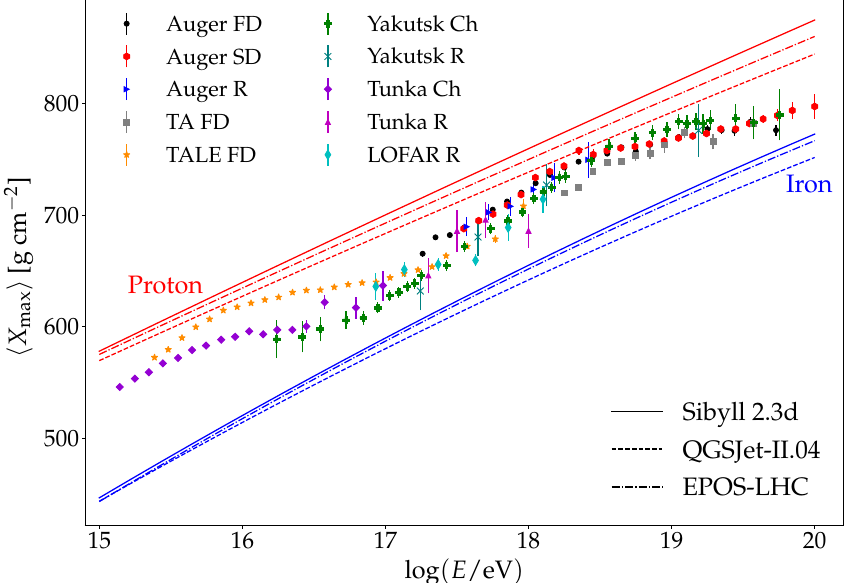
Figure 7. Mean value of X max as a function of the logarithmic energy measured by different ex- periments. FD, Ch, and R in the legend refer to fluorescence, Chrerenkov, and radio techniques, respectively. The data of Auger are labeled as: Auger FD [61], Auger SD (in this case, X max is obtained from surface detectors data calibrated with the fluorescence detectors data) [62], and Auger R [56]. The data of Telescope Array are labeled as: TA FD [63] and TALE FD [64]. The data of Yakutsk are labeled as: Yakutsk Ch [50] and Yakutsk R [57]. The data of Tunka are labeled as: Tunka Ch [65] and Tunka R [58]. The data of LOFAR are labeled as: LOFAR R [59]. The curves correspond to model predictions for proton and iron primaries simulated by using different high-energy hadronic interaction